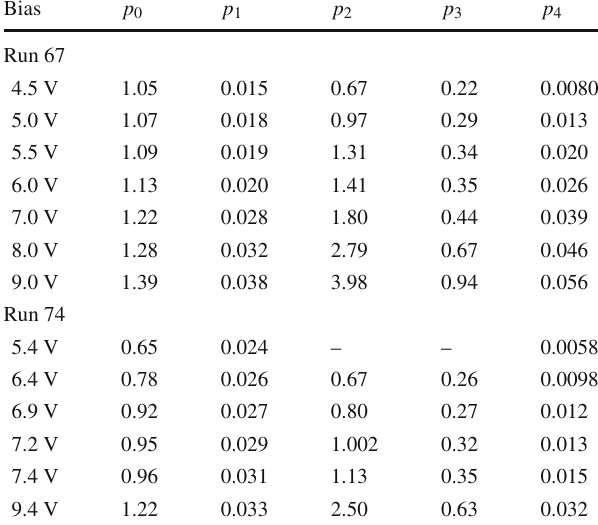
Table 1 A summary of the fit parameters using Eq. (1). Note that the values of p 2 and p 3 are omitted for 5.4 V in Run 74 due to the rate of creating and decreasing A −∗ states was very small, leading to abnormal values for p 2 and p 3 , which do not follow the trend observed at higher bias voltages, where the dependency on the applied bias field is evident Bias